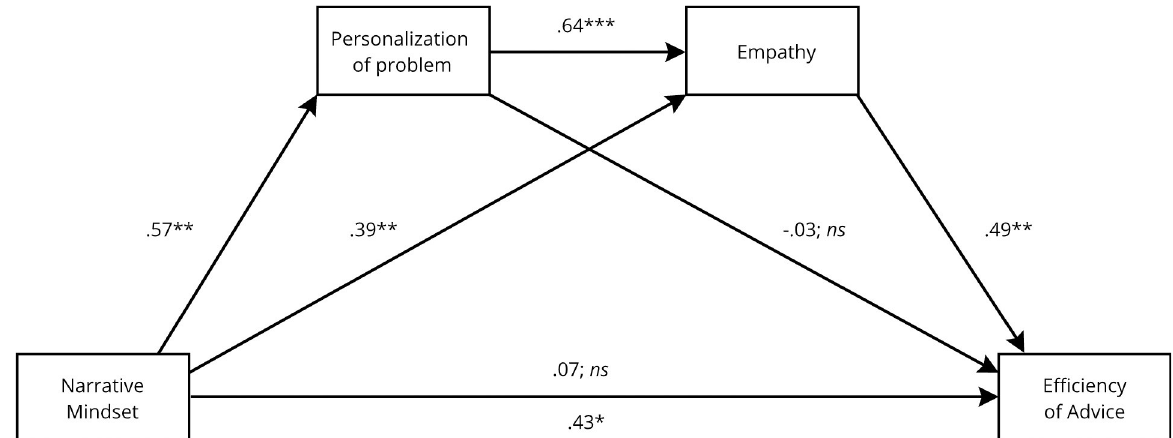
Fig 4. Mediating effect of personalization of problem and empathy on the association between narrative mindset and effectivity of advice– dual-mediation model (the emotional problem-solving study). Note : Presented regression coefficients were partially standardized for the narrative mindset predictor. The remaining were fully standardized. Coding for the independent variable: 0 –control, 1 –experimental. � p < .05. �� p < .01. ��� p < .001.